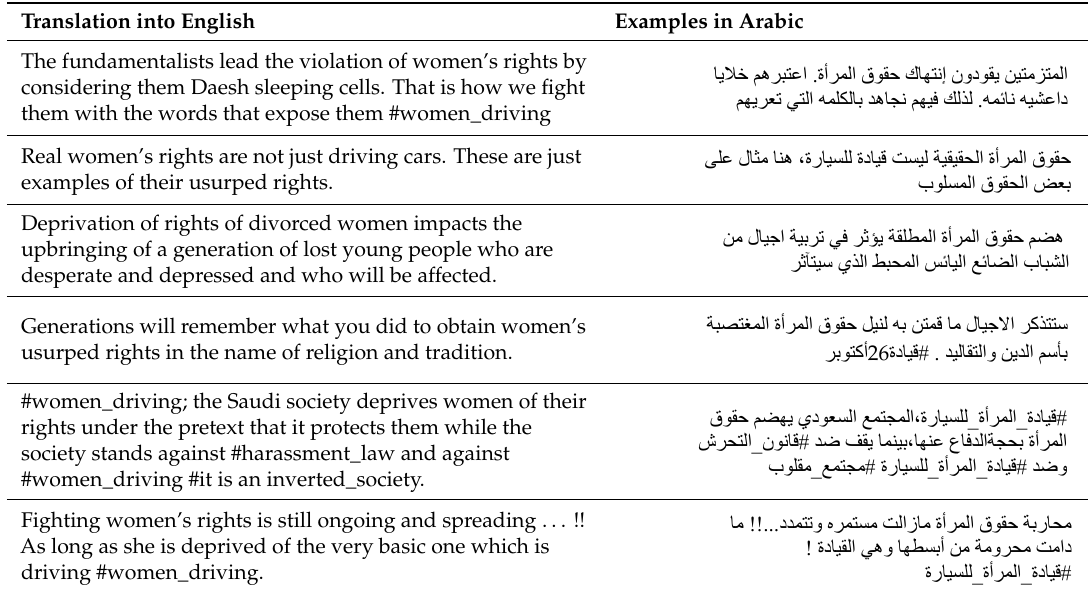
Table 2. Examples of normalizing women driving through victimization.